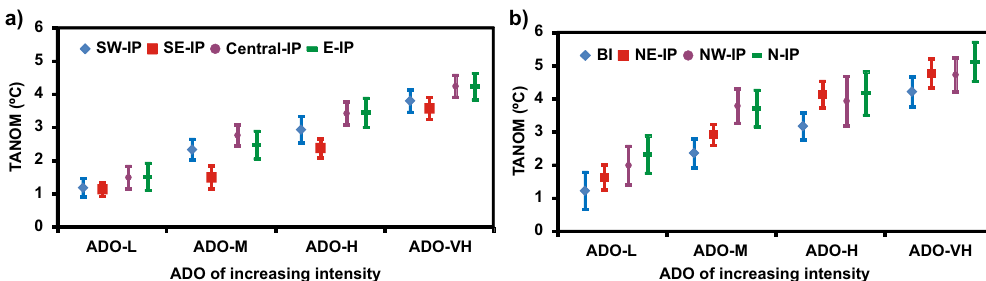
Fig. 3 Impact of ADO of increasing intensity on thermodynamic parameters. Median values (and 95% con fi dence intervals) of anomalies of temperature at 850 hPa (TANOM in °C), in the SW, SE, Central and E regions of the IP ( a ) and in the BI and the NE, NW and N regions of the IP ( b ) during ADO of increasing intensity in the period 2001 – 2020. ADO-L low event, ADO-M moderate event, ADO-H high event, ADO-VH very high event, IP Iberian Peninsula, BI Balearic